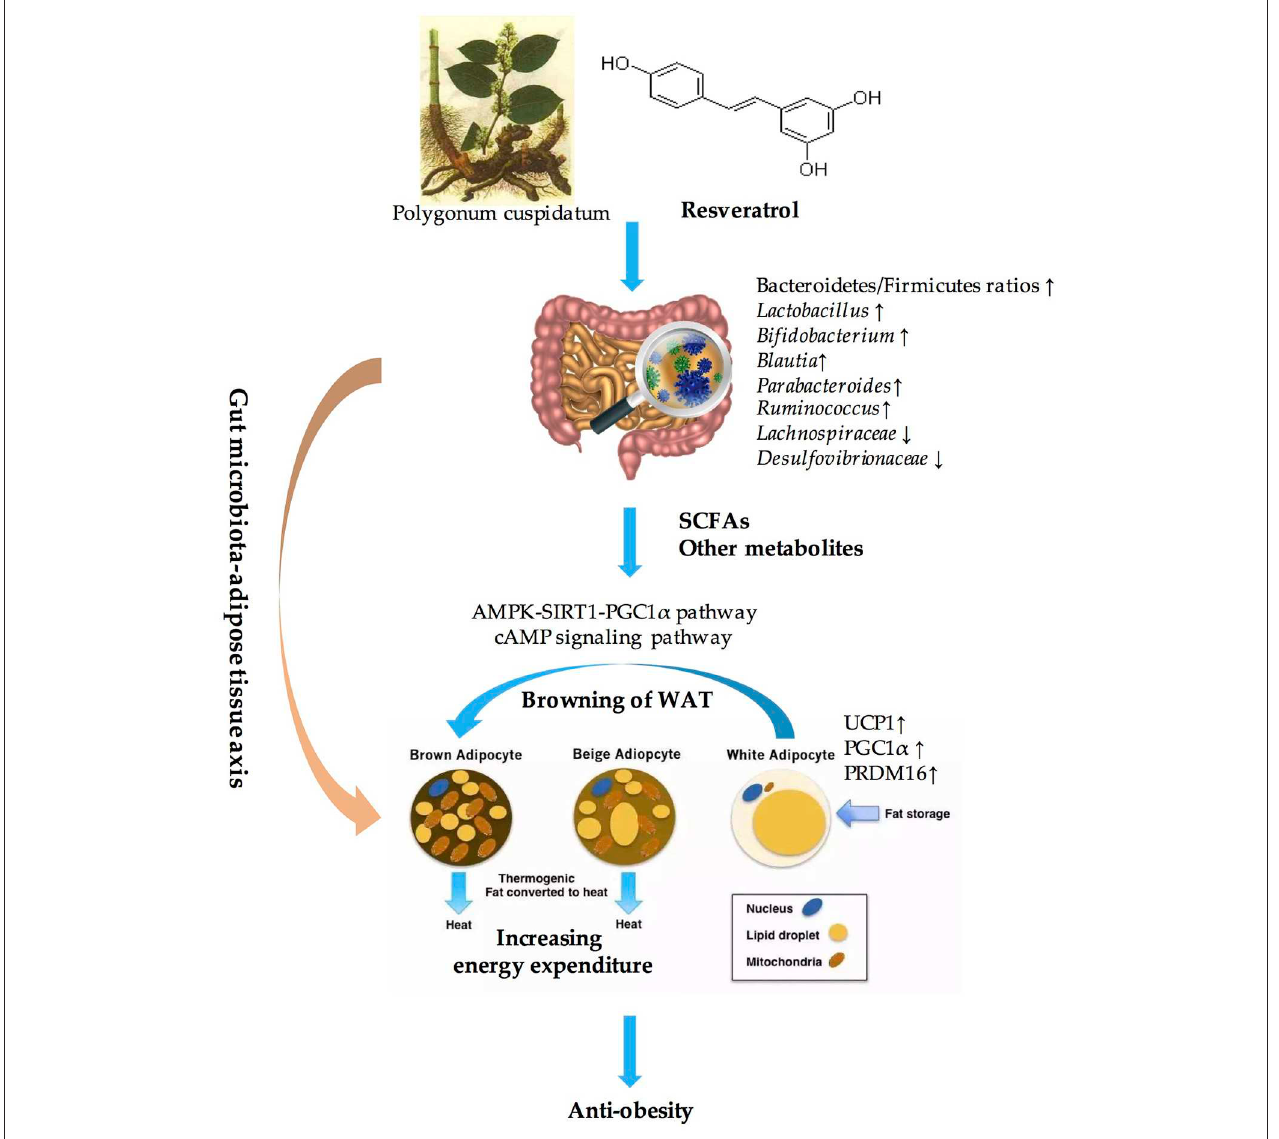
FIGURE 1 | Overview of the role of “Gut microbiota-adipose tissue axis” in the anti-obesity benefits of resveratrol. SCFAs, short-chain fatty acids; AMPK, AMP-activated protein kinase; SIRT1, sirtuin1; UCP1, uncouple protein 1; PGC1 α , PPAR γ coactivator 1 alpha; PRDM16, PRD1-BF-1-RIZ1 homologous domain protein containing protein 16; WAT, white adipose